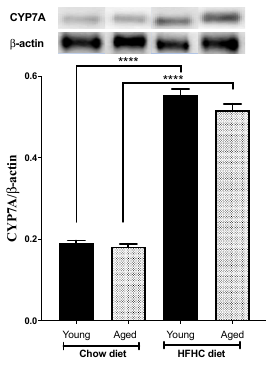
Figure 6. An HFHC diet upregulates CYP7A protein expression by hepatic cells. Young and aged mice were fed chow or an HFHC diet for 12 weeks. They were then euthanized and the CYP7A protein levels were measured in their livers by Western blotting. Data are expressed as means ± SEM , **** p < 0.0001 versus chow.